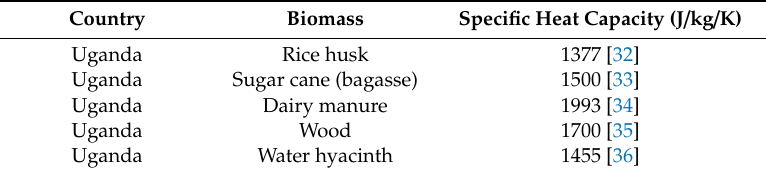
Table 10. Specific heat capacities of common biomasses in their representative